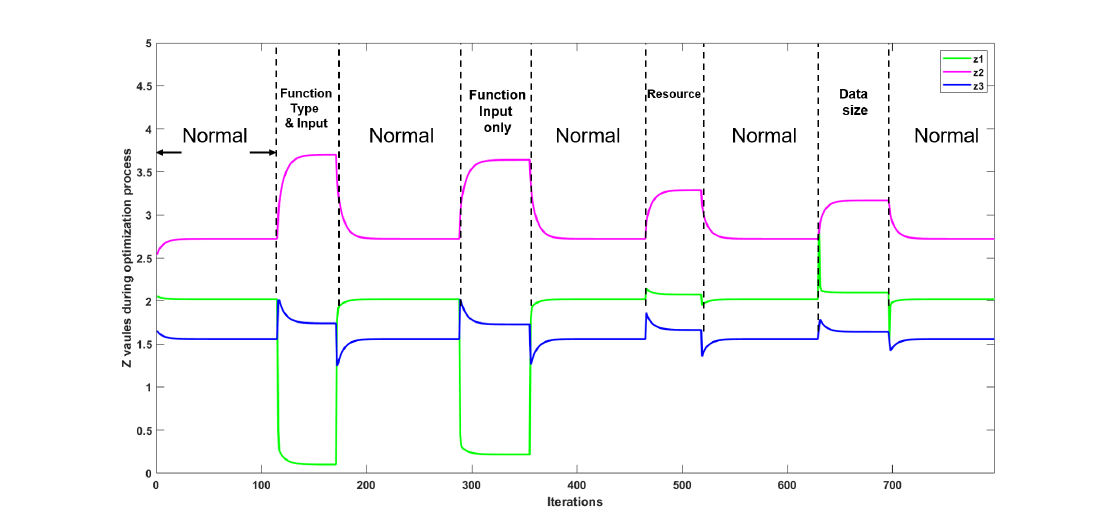
Figure 7. The z values of devices 1, 2, and 3 under different anomalies in the